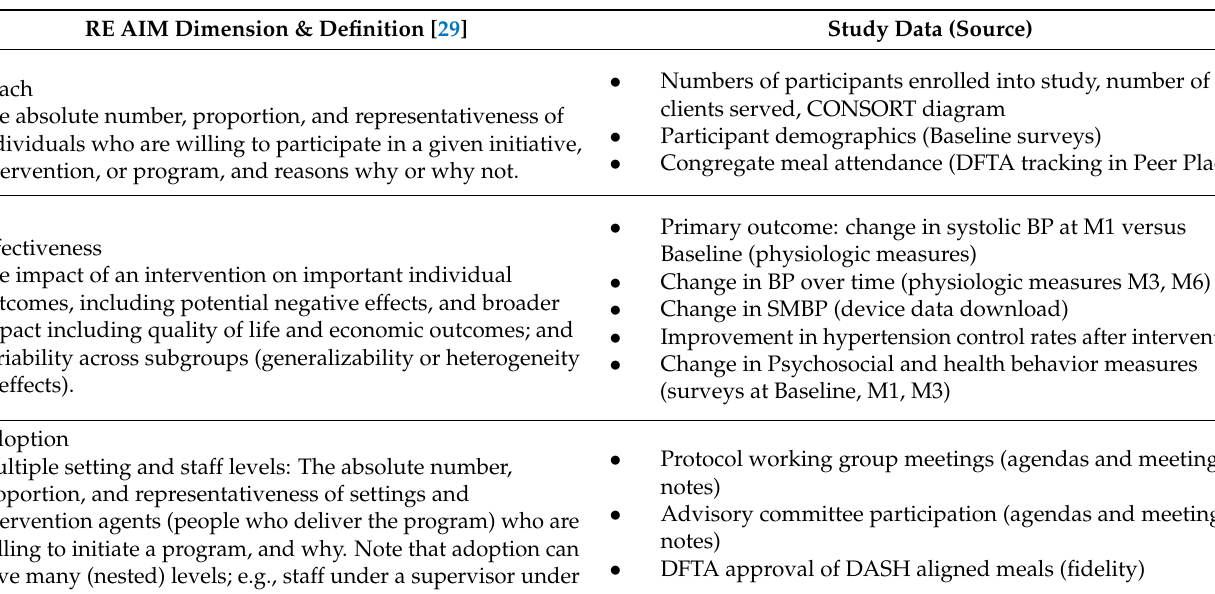
Table 1. Study data sources by RE-AIM